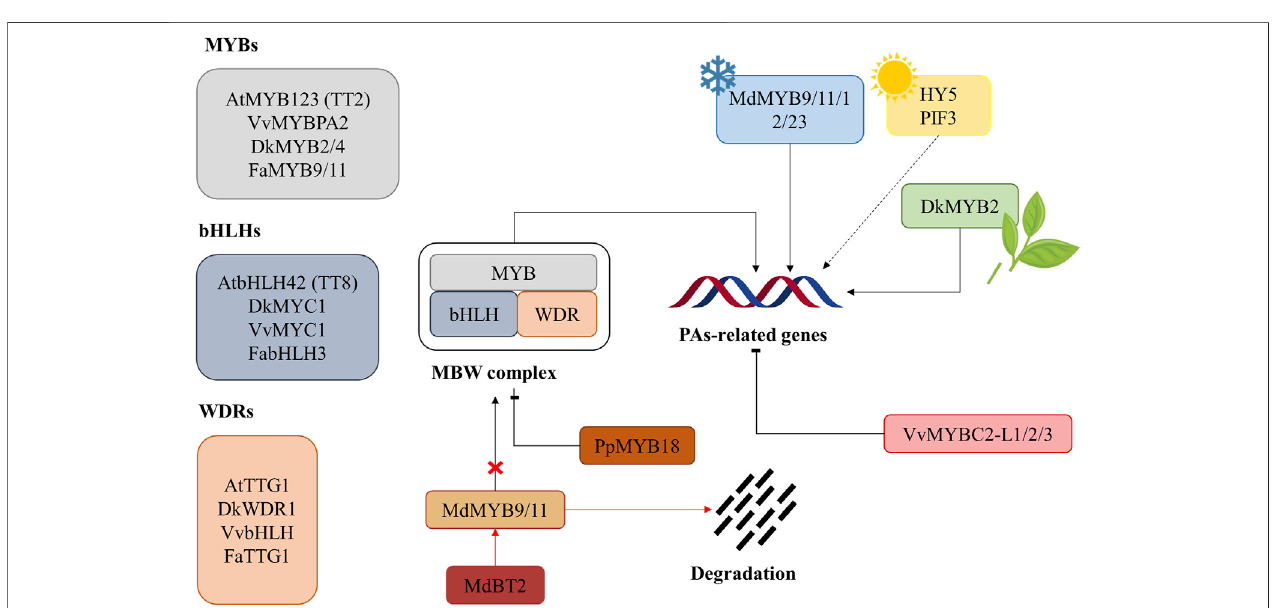
FIGURE4| Generalregulationschemeofproanthocyanidinsynthesis.TheschemeshowsregulationviaMBW-complexformationandcold-,light-andwounding- induced regulation. The degradation of MdMYB9/11 through BT2 and the proteasome is also shown with the red arrows, resulting in the impossibility of these two transcription factors to form the MBW-complex. Arrows indicate positive regulation, while fl at-ended lines mean negative regulation (repression). Dotted lines indicate a process not fully elucidated. At: Arabidopsis thaliana , Dk: Diospyros kaki , Fa: Fragaria x ananassa , Md: Malus domestica , Pp: Prunus persica , Vv: Vitis vinifera .